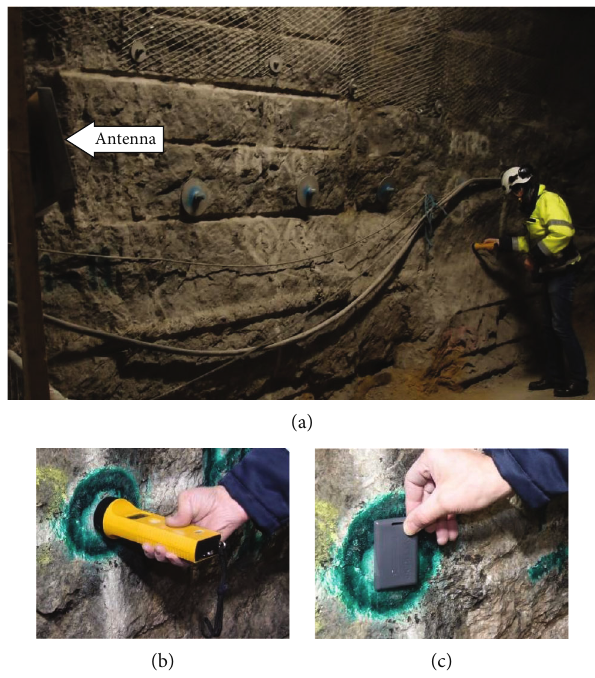
Figure 4: View of the measurement (a), susceptibility measurement (b), and RSSI value measurement (c).